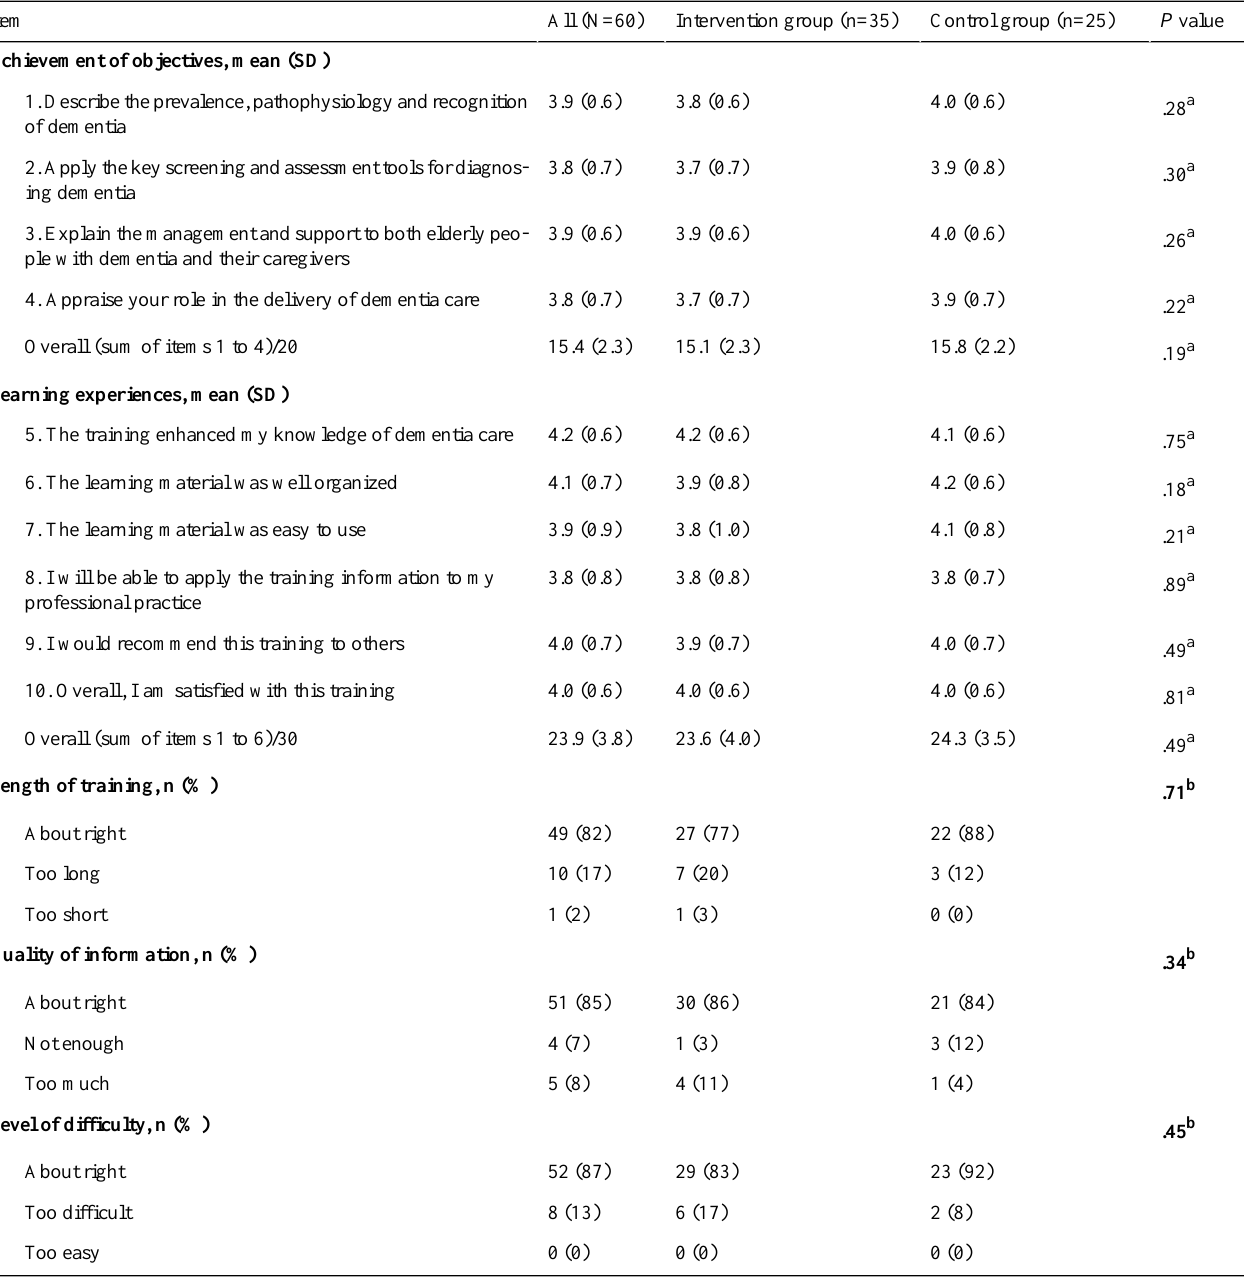
Table 5. Participant satisfaction with the educational